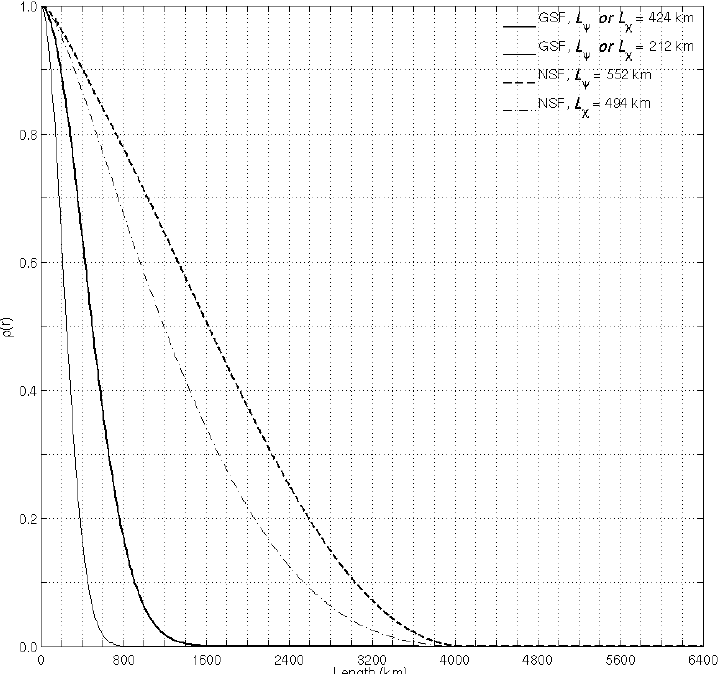
Figure 2. The background error correlation functions used in the 2D-Var analysis. Gaussian structure functions (GSF) are in solid curves (thin curve for Tropics and bold curve for extratropics), and empirical background error correlation (EBEC) functions are in dashed curves (thin curve for velocity potential and bold curve for stream function). Figure is adapted from ref. [19] with per- mission.